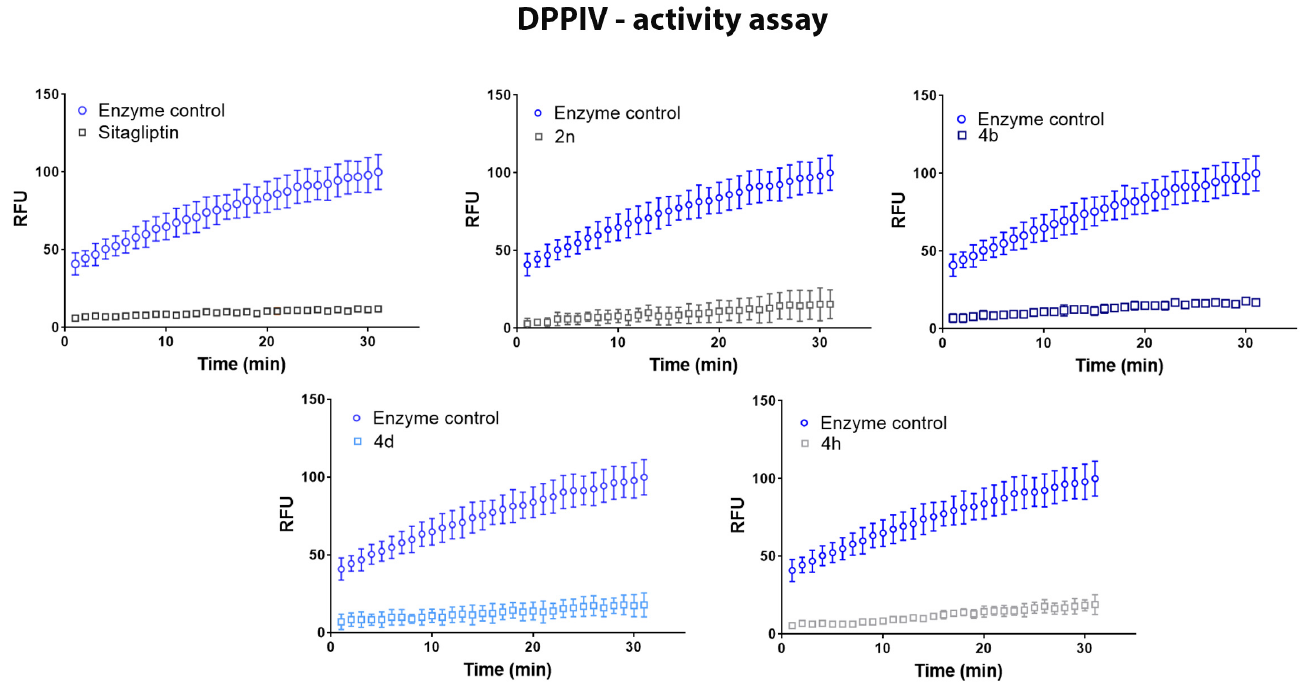
Table 2. DPPIV inhibitory activity of the tested compounds at 100 µM and IC 50 values obtained in DPPIV assay by fitting the percent enzymatic activity after treatment with the indicated compounds at 0.01, 0.1, 1, 10 and 100 µM. Compound